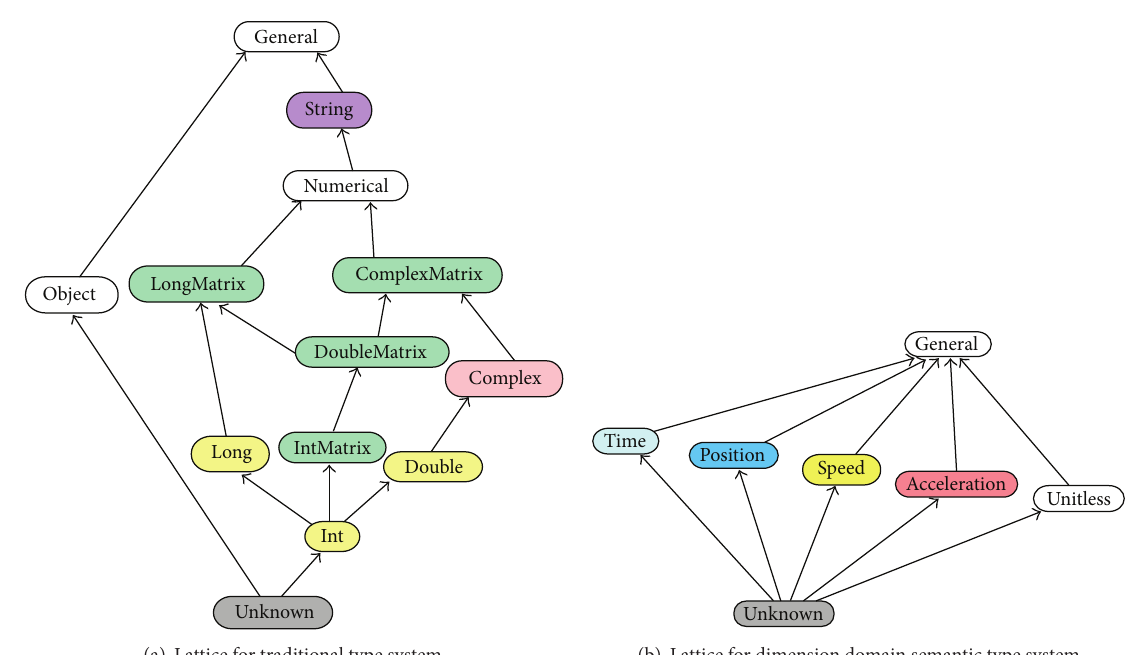
Figure 3: Two typical concept